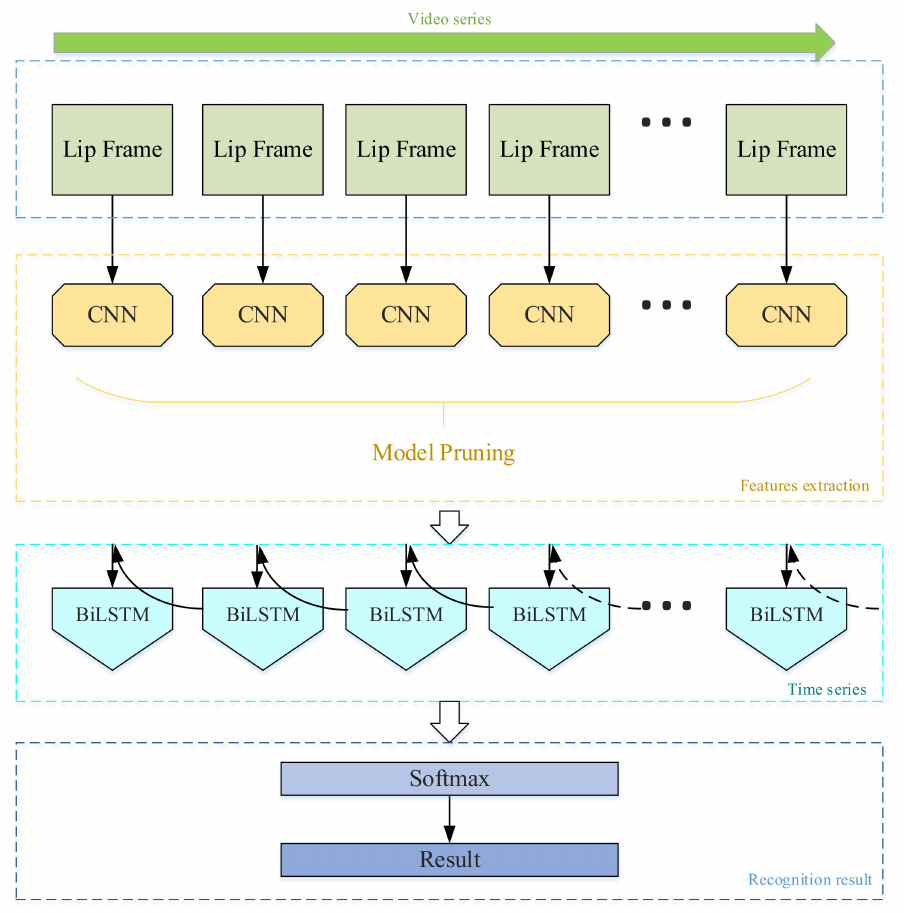
Figure 4. Network structure